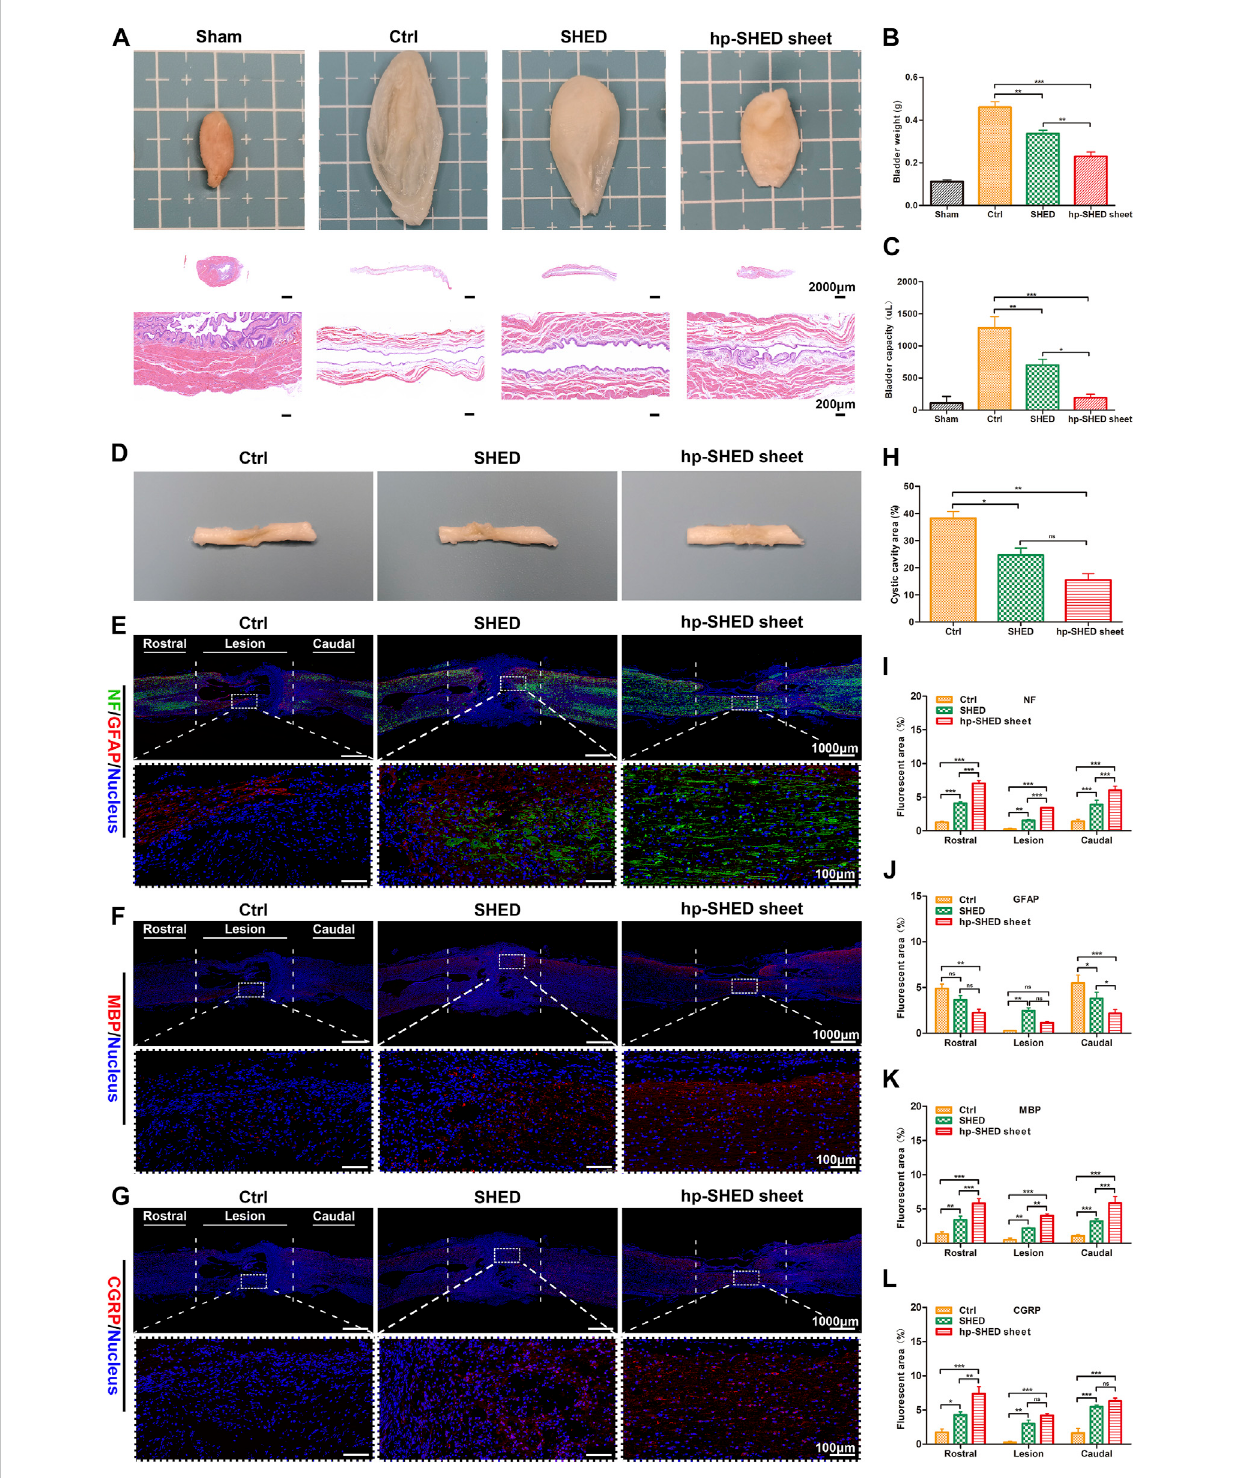
FIGURE 3 Histological mechanisms underlying sensory and motor recovery. (A) Representative images and HE staining of bladders from rats in the indicated group. (B – C) Quanti fi cation and comparison of bladder weight and capacity in the indicated groups. (D – G) Spinal cord representative images and IF staining of NF (green) and GFAP (red), MBP (red), CGRP (red), in Ctrl, SHED and hp-SHED sheet. Images below showed the magni fi ed views of the lesion area that are boxed in the above images. (H – L) Quanti fi cation and comparison of NF, GFAP, MBP, CGRP expression and cystic cavity area. (mean ± SD, * p < 0.05, ** p < 0.01, *** p < 0.001, ns = no signi fi